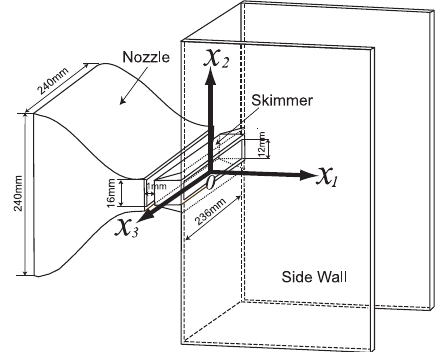
Fig. 8 Coordinate system of Two-dimensional jet flow